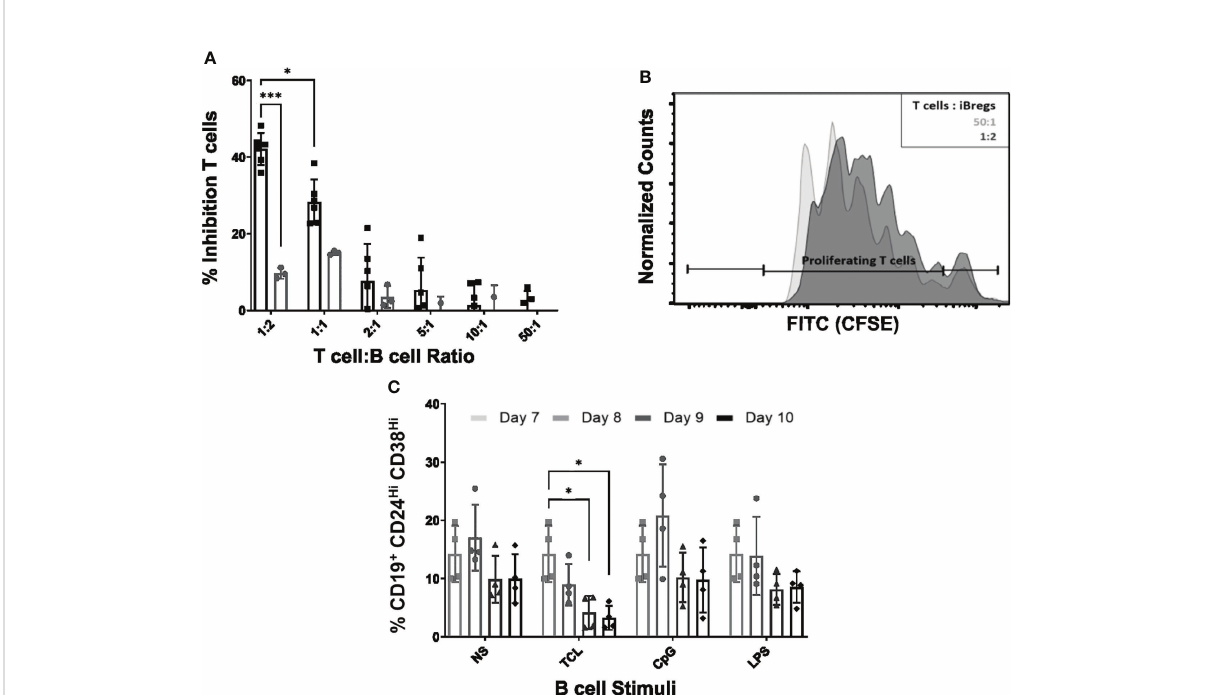
FIGURE 2 iBreg suppress T cell proliferation. iBreg stability was analyzed after day 7 in the absence of MSC showing high stability. (A) T cell proliferation assay showing percentage of MFI (median fl uorescence intensity) reduction for each condition compared to stimulated T cells. iBreg inhibited T cell proliferation at high B to T cell ratios (B) Histogram representing CFSE expression on T cells (C) Graph represents iBreg transitional B cell populations in stability assays. Figure represents transitional values grouped by stimuli condition. iBreg were for the most parts stable under different stimuli after coculture with MSC. Only signi fi cantly different condition was TCL stimuli, decreasing the percentage of transitional B cell. Data shows at least three independent experiments in each group. Cells from 2 MSC donors and 3 Tonsil donors were used. Error bars represent SD. Two-way ANOVA was performed to determine statistical signi fi cance. *p < 0.05, ***p <